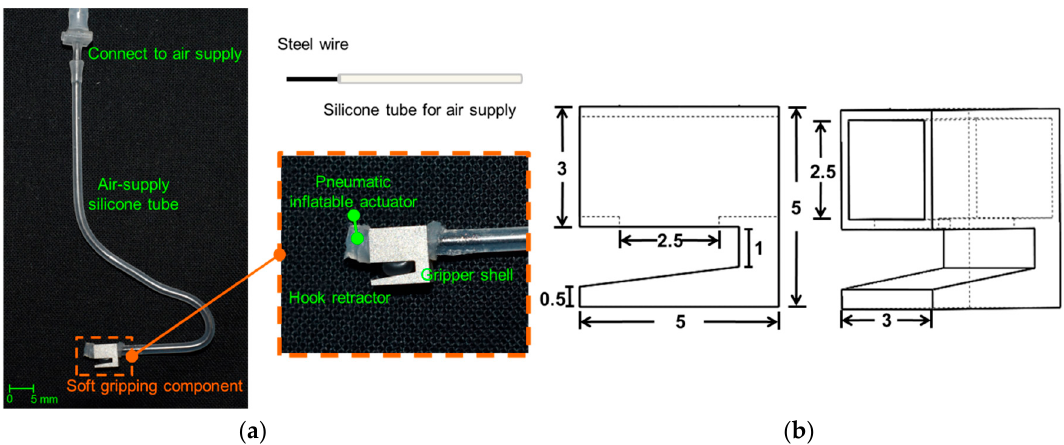
Figure 2. A prototype of the hybrid surgical gripper for nerve manipulation: ( a ) the soft gripping component; ( b ) the size of the prototype (dimensions in millimeters).